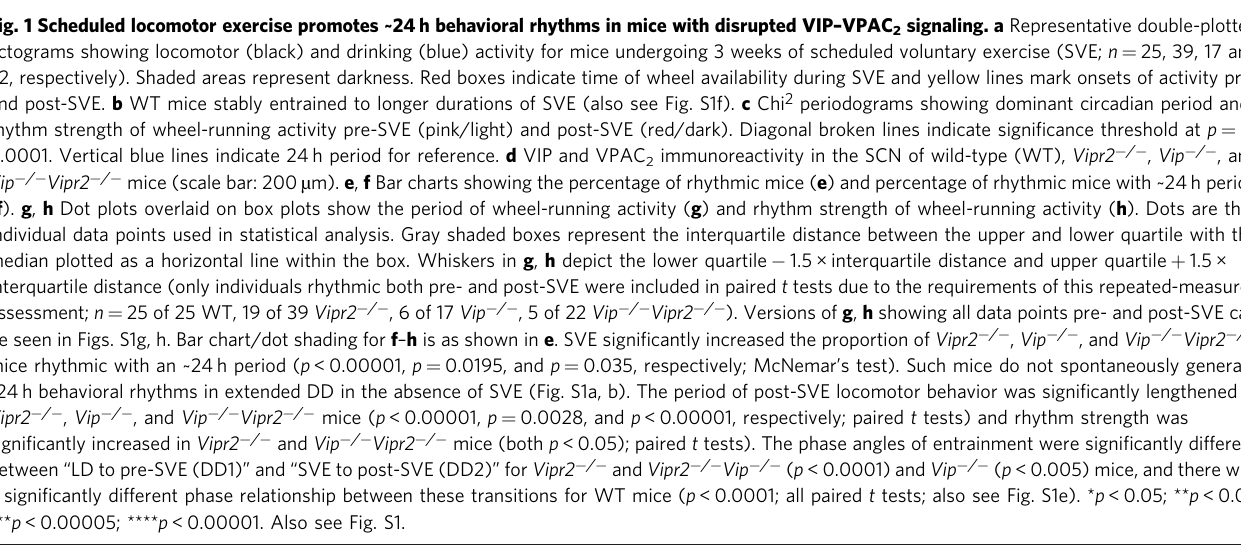
Fig. 1 Scheduled locomotor exercise promotes ~24 h behavioral rhythms in mice with disrupted VIP – VPAC 2 signaling. a Representative double-plotted actograms showing locomotor (black) and drinking (blue) activity for mice undergoing 3 weeks of scheduled voluntary exercise (SVE; n = 25, 39, 17 and 22, respectively). Shaded areas represent darkness. Red boxes indicate time of wheel availability during SVE and yellow lines mark onsets of activity pre- and post-SVE. b WT mice stably entrained to longer durations of SVE (also see Fig. S1f). c Chi 2 periodograms showing dominant circadian period and rhythm strength of wheel-running activity pre-SVE (pink/light) and post-SVE (red/dark). Diagonal broken lines indicate signi fi cance threshold at p = 0.0001. Vertical blue lines indicate 24 h period for reference. d VIP and VPAC 2 immunoreactivity in the SCN of wild-type (WT), Vipr2 − / − , Vip − / − , and Vip − / − Vipr2 − / − mice (scale bar: 200 µ m). e , f Bar charts showing the percentage of rhythmic mice ( e ) and percentage of rhythmic mice with ~24 h period ( f ). g , h Dot plots overlaid on box plots show the period of wheel-running activity ( g ) and rhythm strength of wheel-running activity ( h ). Dots are the individual data points used in statistical analysis. Gray shaded boxes represent the interquartile distance between the upper and lower quartile with the median plotted as a horizontal line within the box. Whiskers in g , h depict the lower quartile − 1.5 × interquartile distance and upper quartile + 1.5 × interquartile distance (only individuals rhythmic both pre- and post-SVE were included in paired t tests due to the requirements of this repeated-measures assessment; n = 25 of 25 WT, 19 of 39 Vipr2 − / − , 6 of 17 Vip − / − , 5 of 22 Vip − / − Vipr2 − / − ). Versions of g , h showing all data points pre- and post-SVE can be seen in Figs. S1g, h. Bar chart/dot shading for f – h is as shown in e . SVE signi fi cantly increased the proportion of Vipr2 − / − , Vip − / − , and Vip − / − Vipr2 − / − mice rhythmic with an ~24 h period ( p < 0.00001, p = 0.0195, and p = 0.035, respectively; McNemar ’ s test). Such mice do not spontaneously generate ~24 h behavioral rhythms in extended DD in the absence of SVE (Fig. S1a, b). The period of post-SVE locomotor behavior was signi fi cantly lengthened in Vipr2 − / − , Vip − / − , and Vip − / − Vipr2 − / − mice ( p < 0.00001, p = 0.0028, and p < 0.00001, respectively; paired t tests) and rhythm strength was signi fi cantly increased in Vipr2 − / − and Vip − / − Vipr2 − / − mice (both p < 0.05); paired t tests). The phase angles of entrainment were signi fi cantly different between “ LD to pre-SVE (DD1) ” and “ SVE to post-SVE (DD2) ” for Vipr2 − / − and Vipr2 − / − Vip − / − ( p < 0.0001) and Vip − / − ( p < 0.005) mice, and there was a signi fi cantly different phase relationship between these transitions for WT mice ( p < 0.0001; all paired t tests; also see Fig. S1e). * p < 0.05; ** p < 0.01; *** p < 0.00005; **** p < 0.00001. Also see Fig.